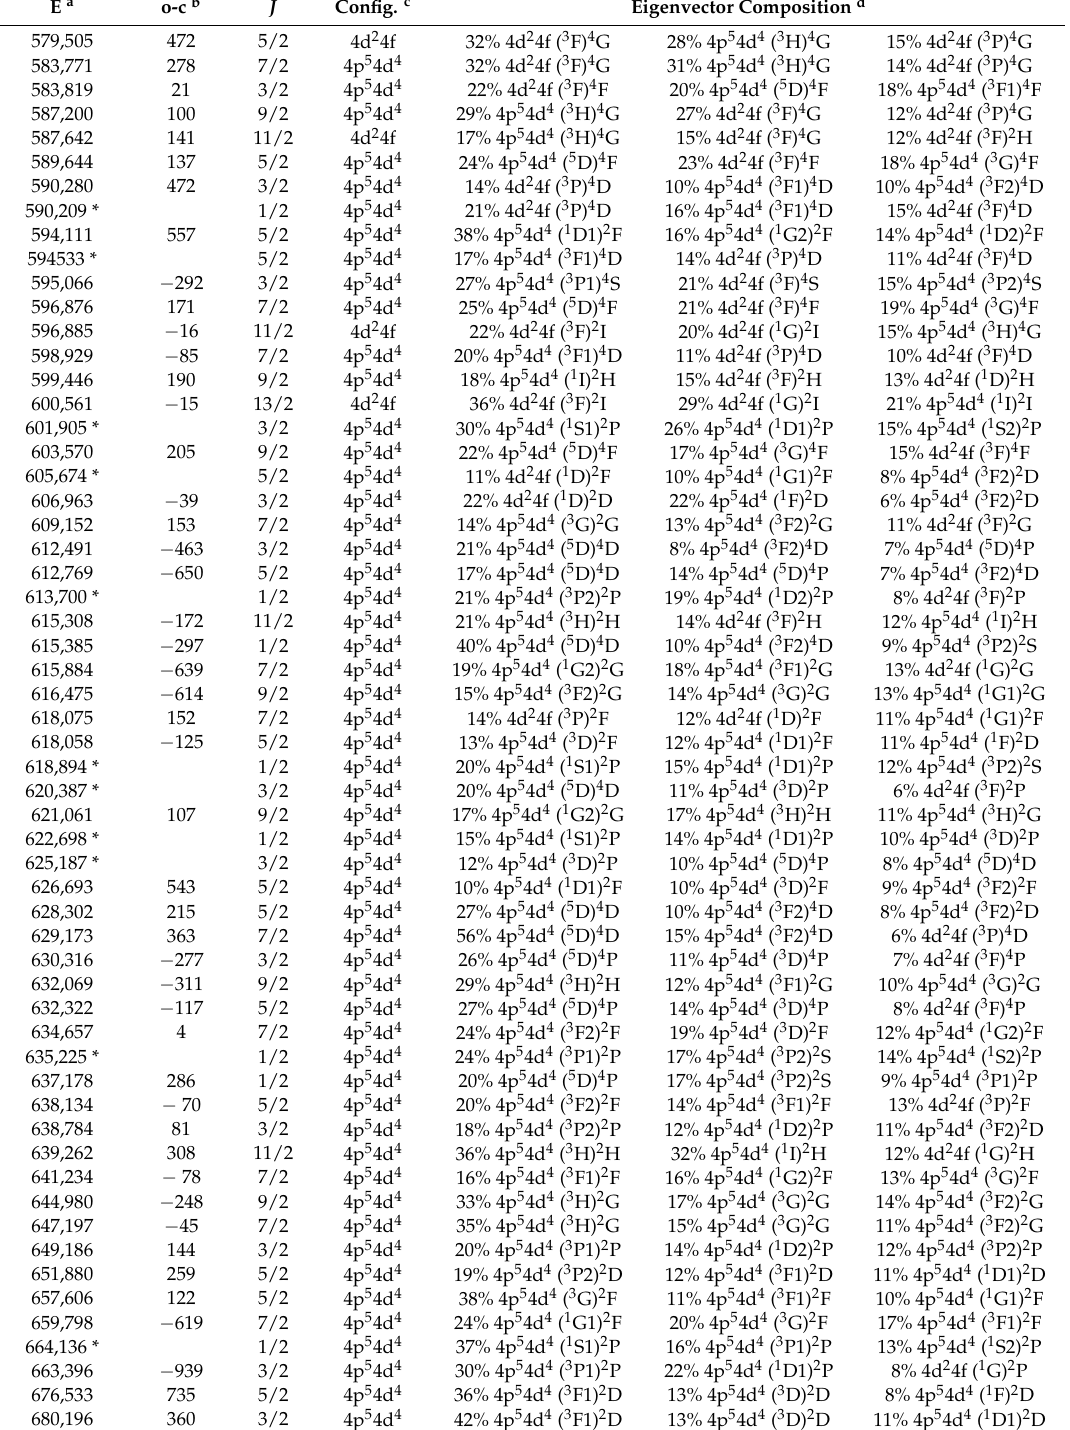
a The star * indicates a calculated value for the level; b The difference between the observed and the calculated energies; c Configuration attribution is arbitrary in a few cases (see text); d For the eigenvector composition, up to three components with the largest percentages in the LS-coupling scheme are listed. The number following the terms of the 4d 4 configuration displays Nielson and Koster sequential indices